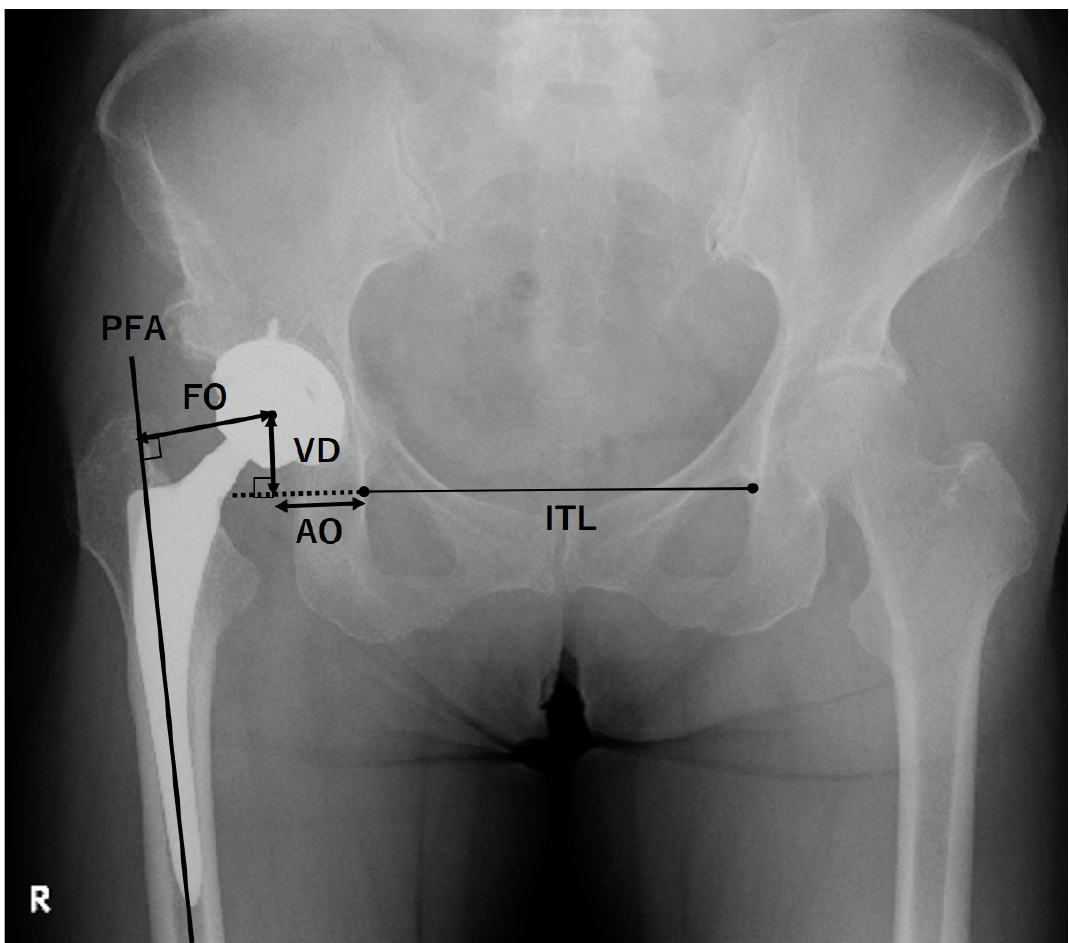
Figure 2. Radiographic indices measured on the anteroposterior radiographs. The interteardrop line (ITL) connects the inferior edges of both teardrops. The acetabular offset (AO) was measured as the horizontal distance from the inferior edge of the teardrop to the point where an extension of the ITL intersects with a perpendicular line drawn from the hip joint center. The vertical distance (VD) was measured as the distance from the hip joint center to the point where the extension of the ITL inter- sects with the perpendicular line from the hip joint center. The femoral offset (FO) was measured as the distance from the hip joint center to the intersection with the proximal femoral shaft axis (PFA). The global offset was measured as the sum of FO and AO.